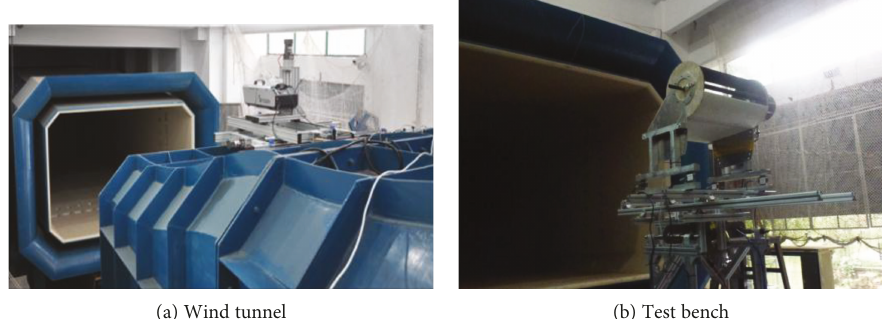
Figure 8: Experiment of the Fan-wing.